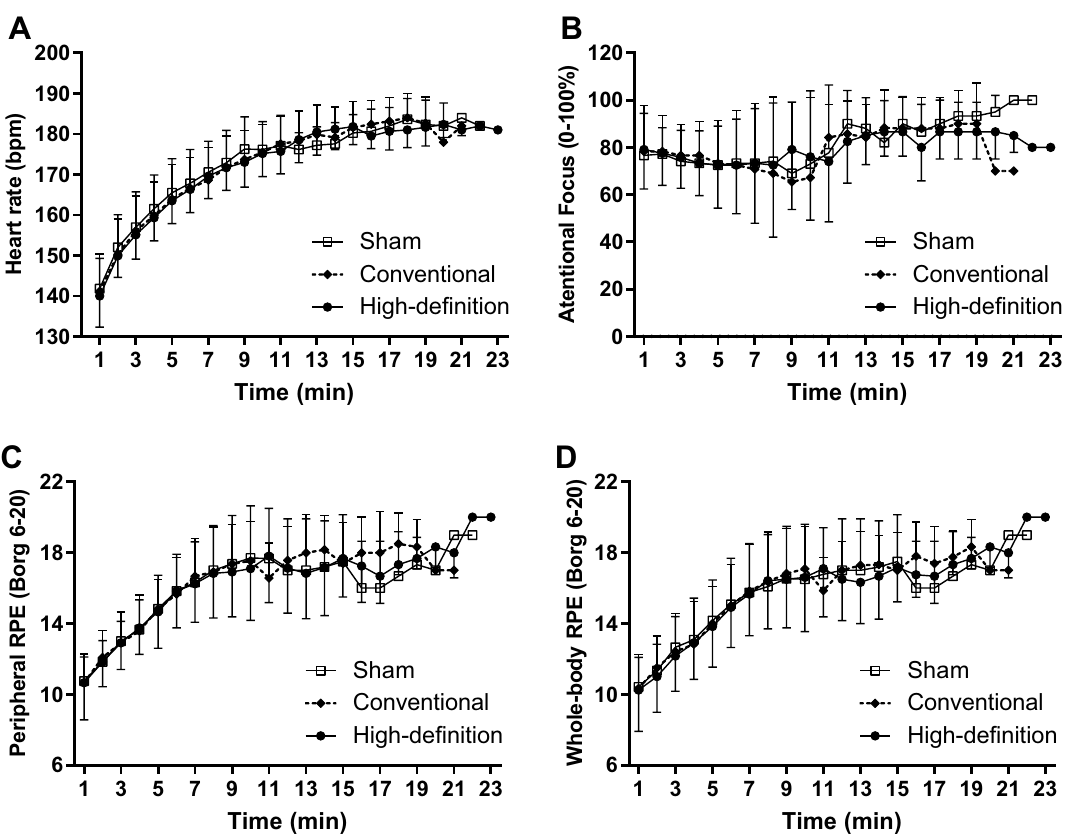
Figure 6. Effect of anodal high-definition, conventional, and sham tDCS on heart rate ( A ), associative thoughts ( B ), peripheral ( C ), and whole-body perceived exertion ( D ) during the time to exhaustion test with a constant load at 80% of peak power in athletes (n = 12). The data is presented as the mean and standard